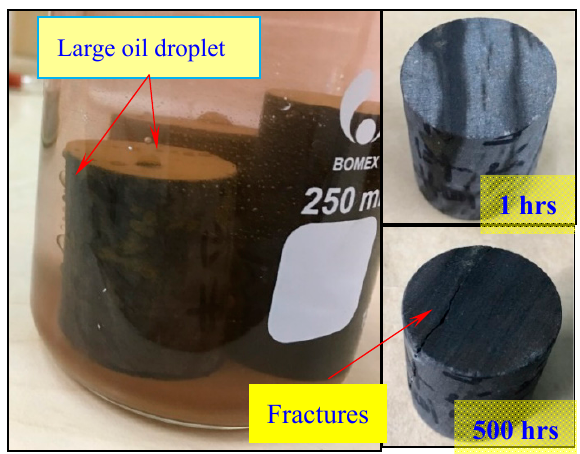
Energies 2019 , 12 , x FOR PEER REVIEW Figure 11. The observations of QT-1 before and after experiments. Figure 11. The observations of QT-1 before and after experiments.